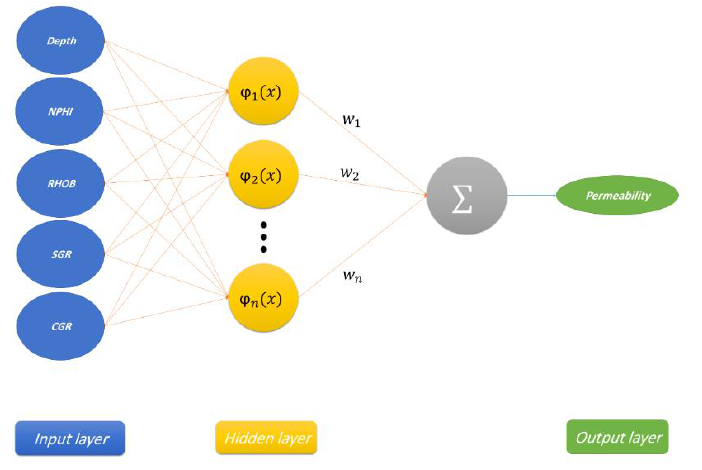
Figure 7. Structure of the RBF network with three